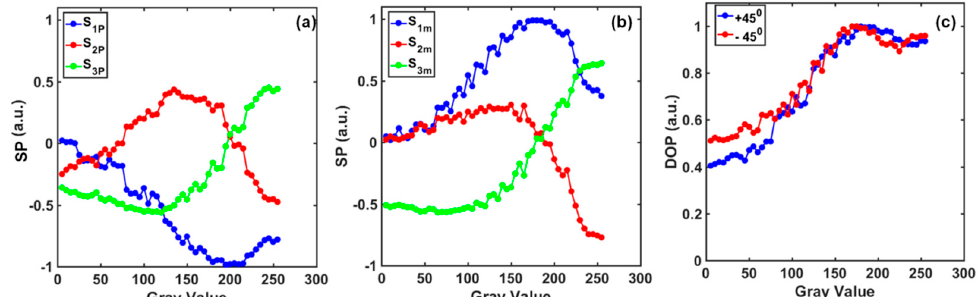
Figure 5. Polarization modulation characteristics of the SLM within its grayscale range (0–255). ( a ) SPP variation ( S 1 P , S 2 P , and S 3 P ) for +45° polarized ( b ) SPP variation ( S 1 m , S 2 m , and S 3 m ) and for − 45° polarized input light; ( c ) DOP variation for +45° polarized (blue plot) and − 45° polarized (red plot) input light.